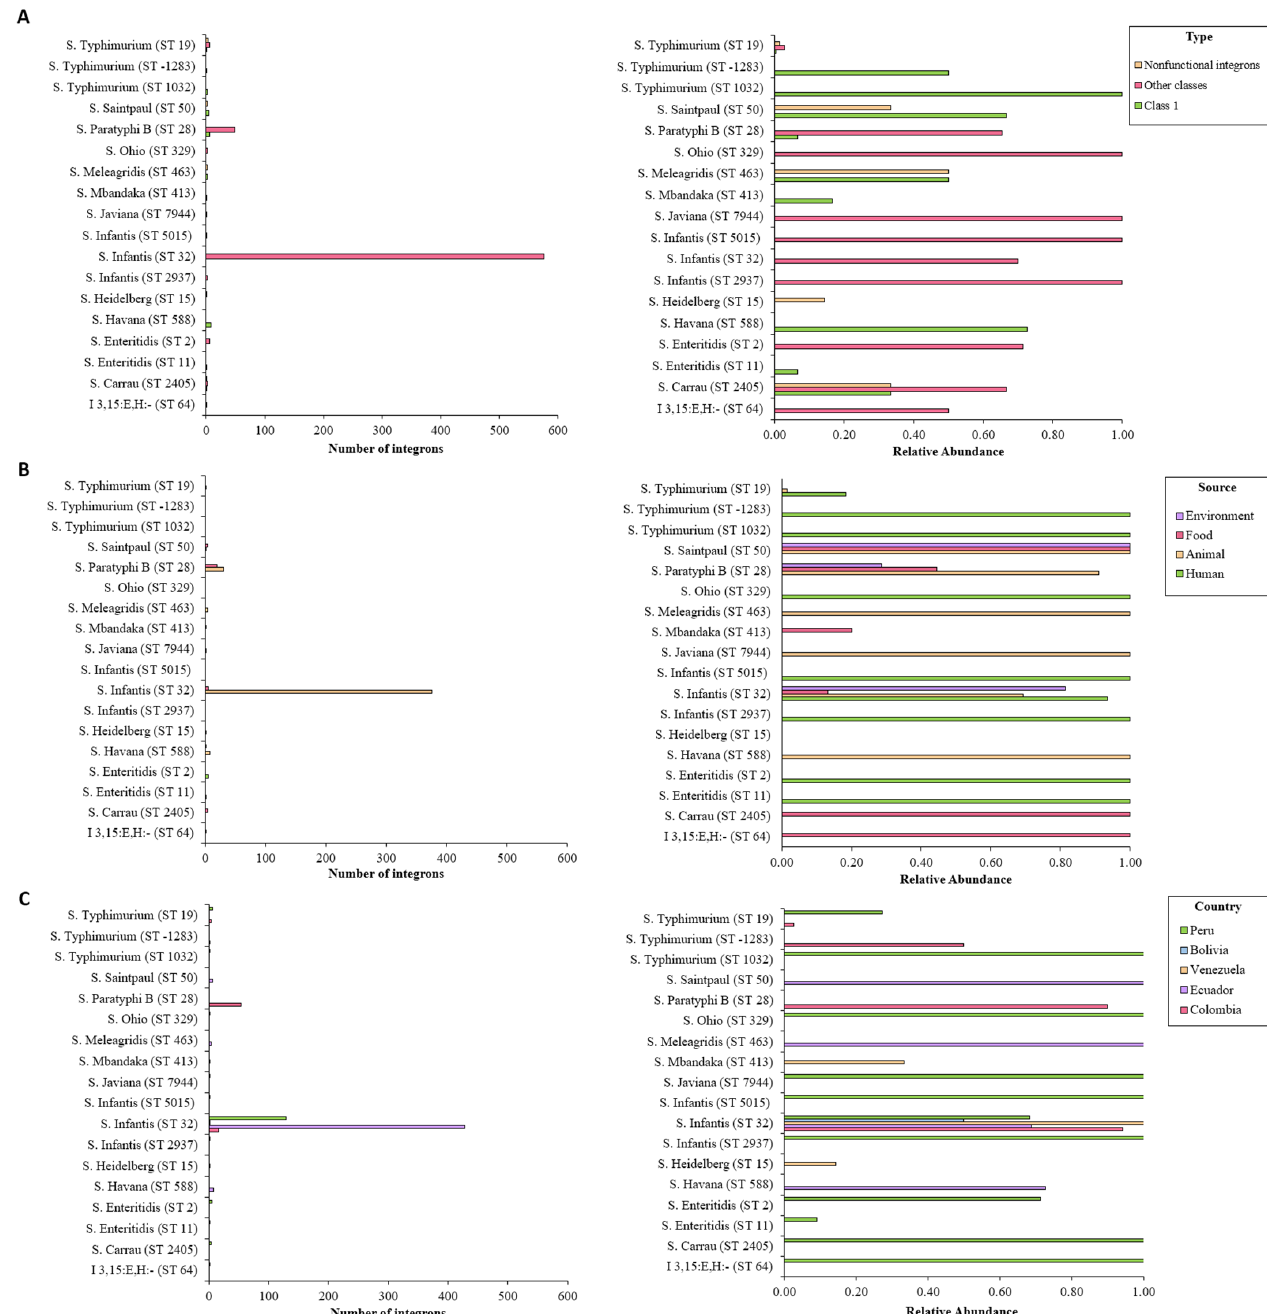
Figure 4. Number of integrons detected by I-VIP v1.2 according to sequence type, organized by ( A ) integron class, ( B ) source, and ( C ) country. Int , integrase.